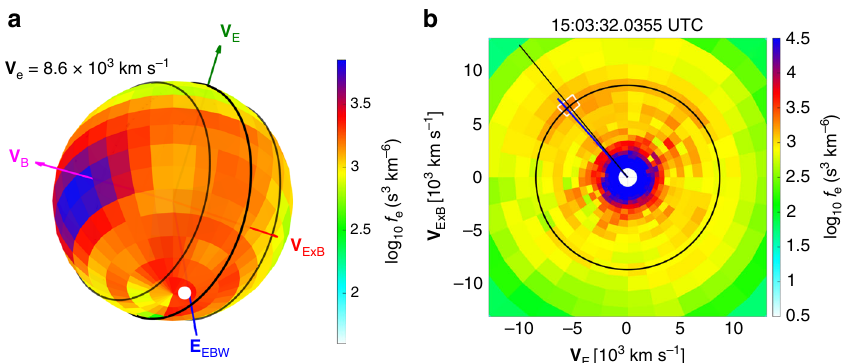
Fig. 7 Two-dimensional (2D) slice from 3D electron distribution functions. a Electron distribution functions with electron kinetic velocity of 8.6 ´ 10 3 km s (cid:1) 1 (corresponding to 212 eV). The green, magenta, and red arrowed lines denote the directions of V E , V B , and V E×B , respectively. The black circle represents the V E − V E×B plane perpendicular to the magnetic fi eld B , and the two dashed circles show the ranges of ± 22 : 5 (cid:5) away from the V E − V E×B plane. The blue arrowed line labeled as E , show the E direction of the EBWs. The white dot in panel ( a ) and the white square in panel ( b ) highlight EBW max the location with the largest phase-space density of the electron crescent. The intense phase-space densities close to the V B direction corresponds to the parallel magnetosheath electrons moving towards the X line (see Fig. 3f). b 2D slice of the distribution function on the V E − V E×B plane is from the average phase-space densities within ± 22 : 5 (cid:5) from the perpendicular plane. The black circle denotes the electron velocity of 8.6 ´ 10 3 km s (cid:1) 1 . The black and blue lines show the projected directions with the peak phase-space density of the electron crescents and the E direction, max in kms (cid:1) 1 ), the parallel speed ( v k ; r , in kms (cid:1) 1 ), and the perpendicular ring speed Table 1 Liouville tracing of the phase-space densities of the ( v ? ; r , in kms (cid:1) 1 ), are listed in Supplementary Data 1. The Maxwellian cores contain crescents in velocity space. 65eV electrons with a number density of 1.35cm (cid:1) 3 and 320eV electrons with a number density of 2.02cm (cid:1) 3 . The parallel-moving Maxwellian electrons have a W number density of 3.38cm (cid:1) 3 , a parallel speed of 8000kms (cid:1) 1 , perpendicular tem- e [eV] perature of 20eV and parallel temperature of 10eV. All the parameters are adjusted to have a best fi tting of the crescents and a relatively good fi tting of the rest. Data availability MMS L2 data are available from the MMS Science Data Center (https://lasp.colorado.